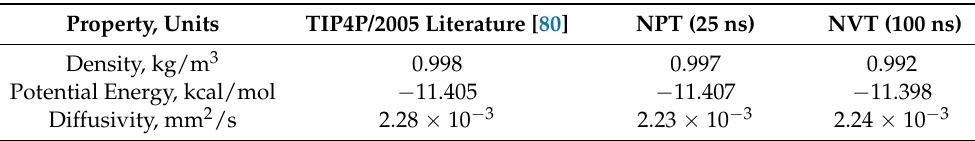
Figure 1. Pure water system at 25 ◦ C and atmospheric pressure ( a ) potential energy (red: literature [80] value, black: mean value); ( b ) diffusivity; and ( c ) density (black: mean value) during 25 ns of an NPT ensemble equilibration simulation. In panels ( a , c ): blue: raw LAMMPS output, orange: average over a 0.4 ns running window. Table 3. A summary of the system’s mean physical properties after the NPT and NVT equilibration simulations and a comparison to expected literature values for a TIP4P/2005 pure water system at 25 ◦ C and atmospheric